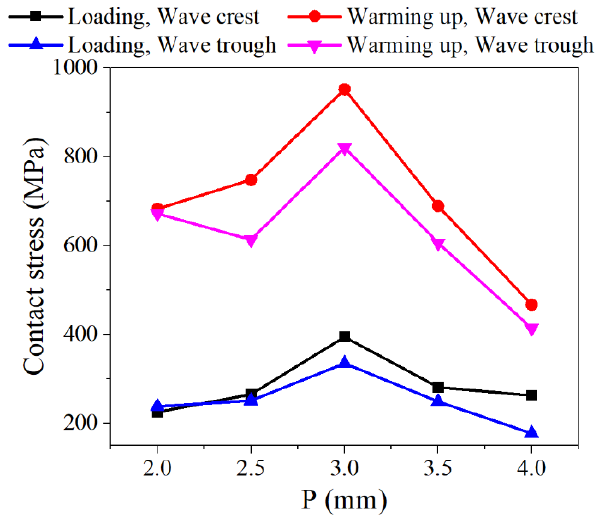
Figure 15. Contact stress distribution of NiTi alloy gasket with different corrugation pitches.